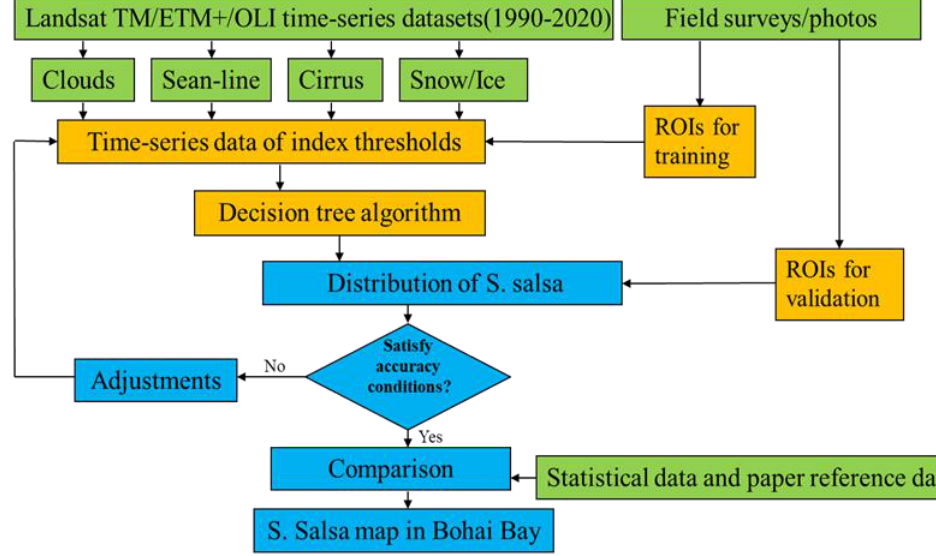
Figure 2. Flow chart of mapping S. salsa using Landsat time-series images from 1990 to 2020.